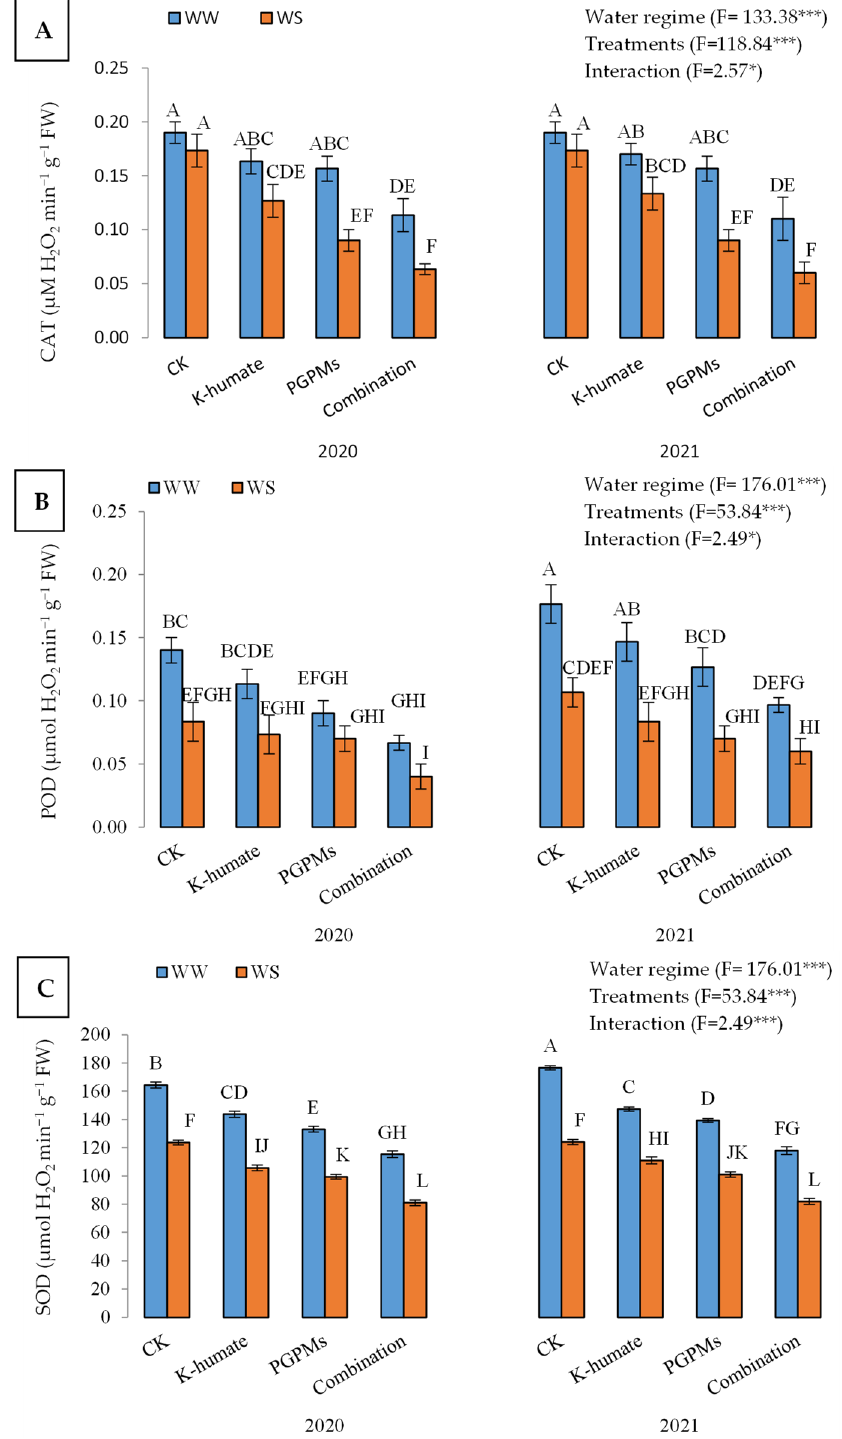
Figure 4. Activities of different antioxidant enzymes: ( A ) catalase (CAT); ( B ) peroxidase (POD), and ( C ) superoxide dismutase (SOD) in soybean seeds ( Glycine max L. cv. Giza 111) leaves, which was cultivated in salt-affected soil and treated with plant growth-promoting microbes (PGPMs; Bradyrhizobium japonicum (USDA 110) and Trichoderma harzianum ), potassium humate (K-humate), and their combination under two water regimes (WS: water deficit regime and WW: well-watered regime) during two consecutive seasons. Different letters above columns show significant differences between treatments according to the Tukey’s test ( p ≤ 0.05). Data are Means ± SD and n = 3. *** denotes significance at p ≤ 0.001, * denotes significance at p ≤ 0.05.